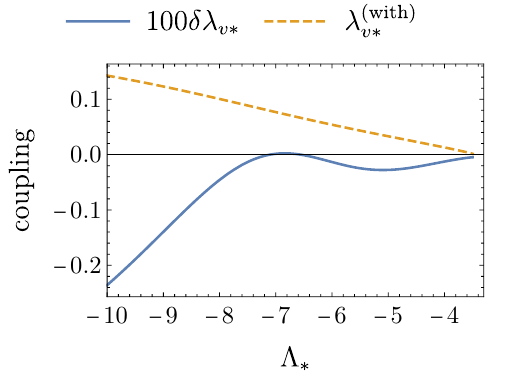
Figure 7 . Difference δλ v ∗ = λ (without) v ∗ − λ (with) v ∗ of the quartic coupling without and with a dark sector for constant fixed-point value of Yukawa coupling, i.e., in a fixed-Yukawa scan. Here λ (without) is computed by solving the full matter beta functions self-consistently. For almost all values of Λ the inclusion of the dark sector leads to larger values of λ